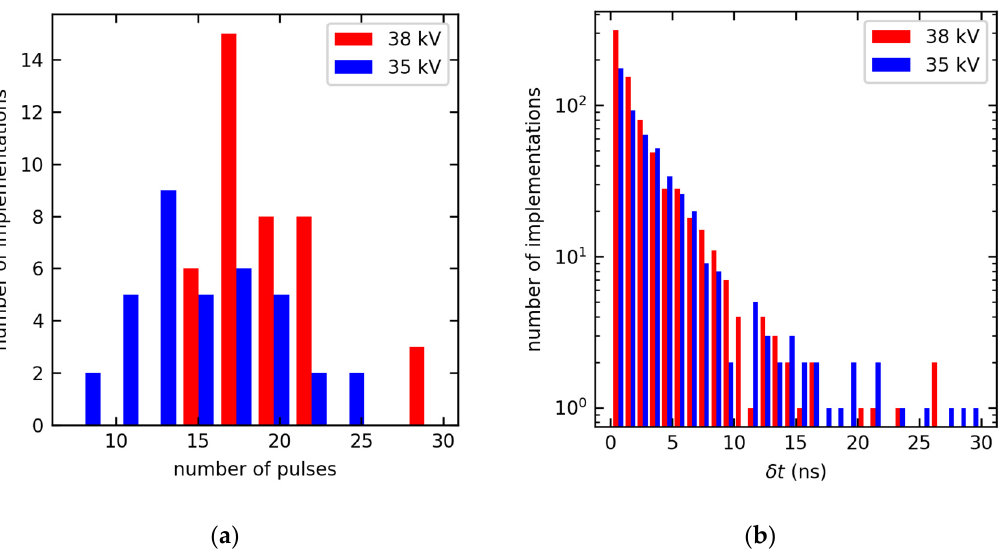
Figure 7. ( a ) Distribution of the number of the subnanosecond pulses detected in each discharge realization. The red and blue colors correspond to the results of the experiments, in which the anode voltage was 38 kV and 35 kV, respectively. ( b ) Distribution of the repetition intervals of the radiation pulses at the same values of the voltage.